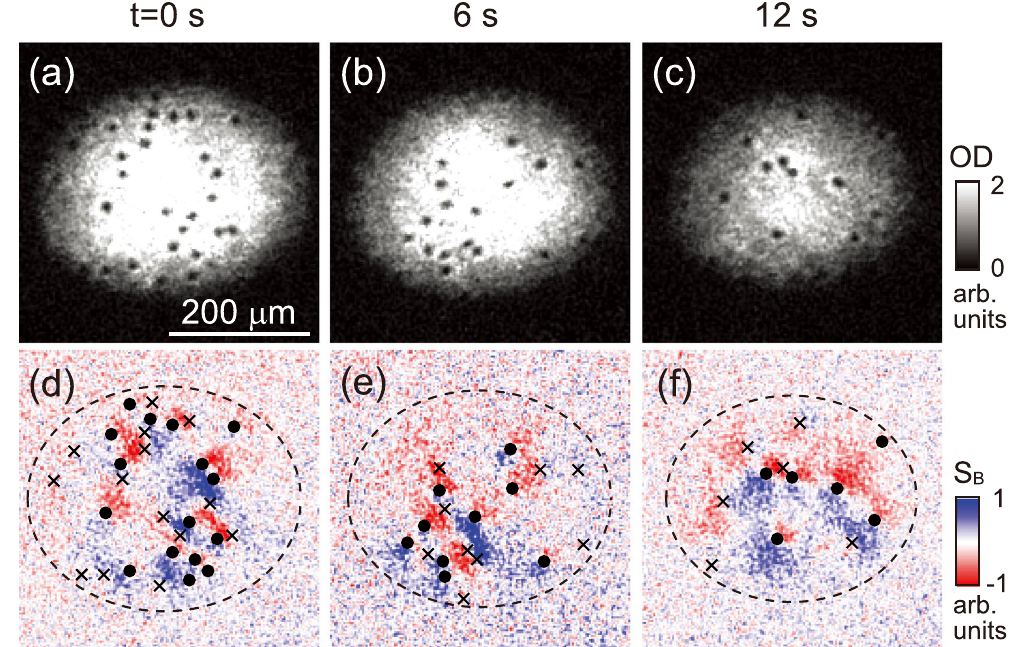
Figure 4. Determination of the vortex configuration of a turbulent BEC. ( a – c ) TOF images of BECs at various hold times t and ( d – f ) the corresponding Bragg signals S B ( x ′ , y ′ ) = n + − n − , where n ± are the density distributions of the ± x ′ -scattered atom clouds. The vortex positions are identified based on the density- depleted holes that appear in the BEC images, and their circulation signs are determined based on S B around the vortex cores (see the text). The circles and crosses denote positive and negative vortices,